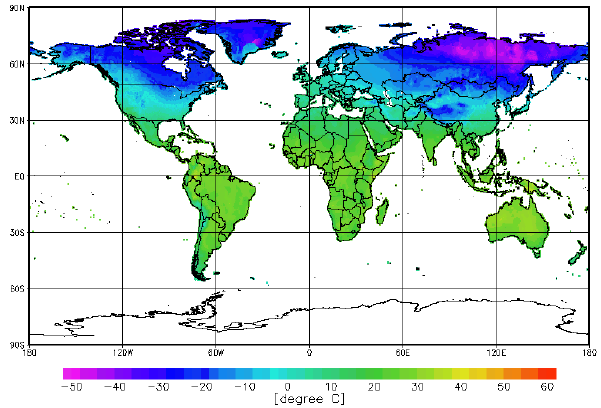
Figure 1. Monthly mean temperature in degrees Celsius for Jan- uary 2014 from the NOAA NCEP CPC GHCN_CAMS gridded data set with the original 0.5 ◦ spatial resolution.